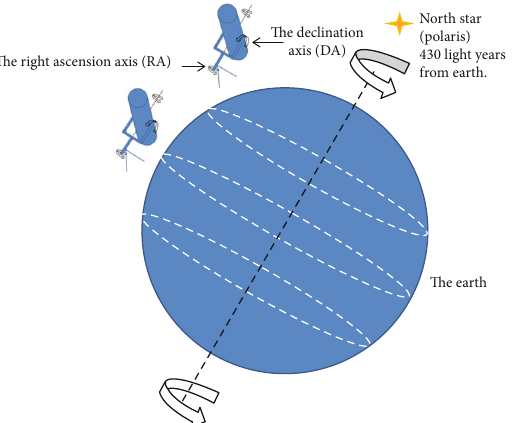
Figure 3: The telescope tracking axis is parallel to the earth ’ s axis of